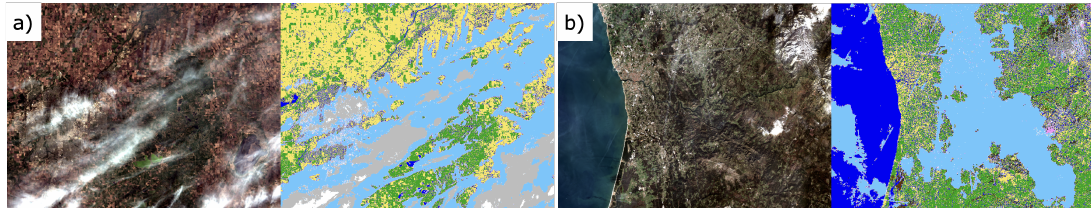
Figure 17. When only the RGB image is used, ( a ) cirrus in Sentinel-2 SCL data may sometimes be visible as shown on the left and ( b ) sometimes invisible as shown on the right. In this study, cirrus is neglected and is considered as a noise